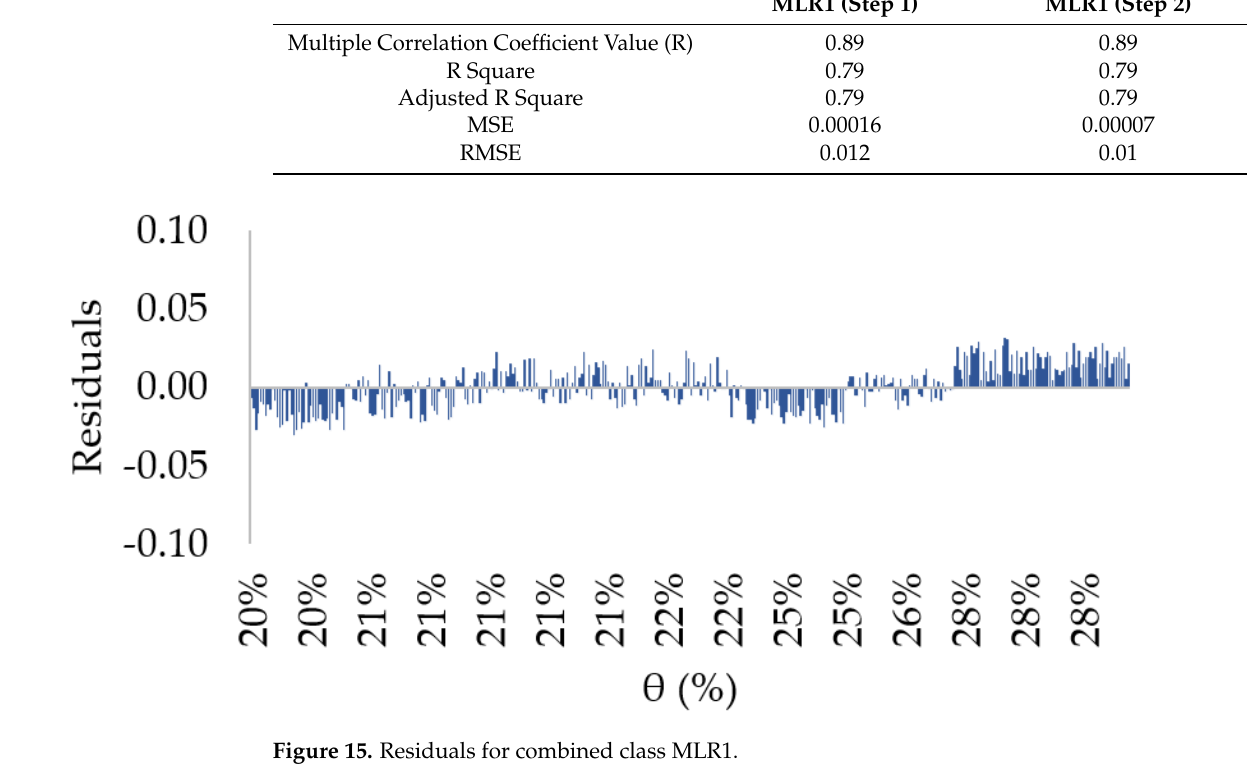
Figure 15. Residuals for combined class MLR1.